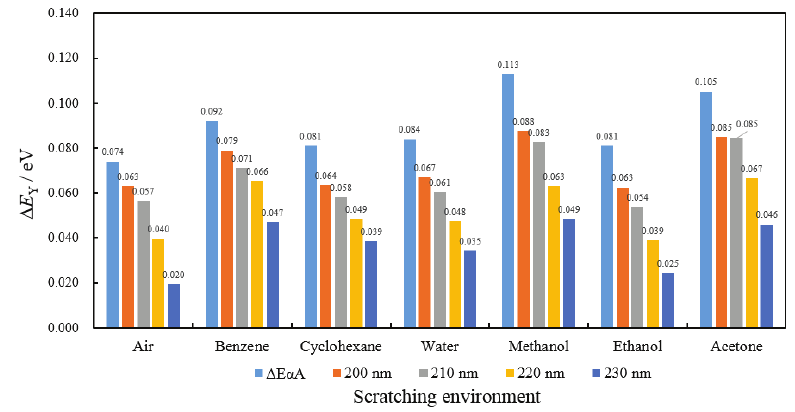
Figure 15. Activation energies of the PE quantum yield (emitted electrons / photon), ∆ E Y , obtained at wavelengths of 200, 210, 220, and 230 nm during the wavelength scan at 25, 200, and 339 ◦ C, together with those of the electron photoemission probability ( ∆ E α A ) for all environments. The values of ∆ E Y come from the mean values of the scan data at two wavelengths, and the values of ∆ E α A are from Table 2 in Reference [7].